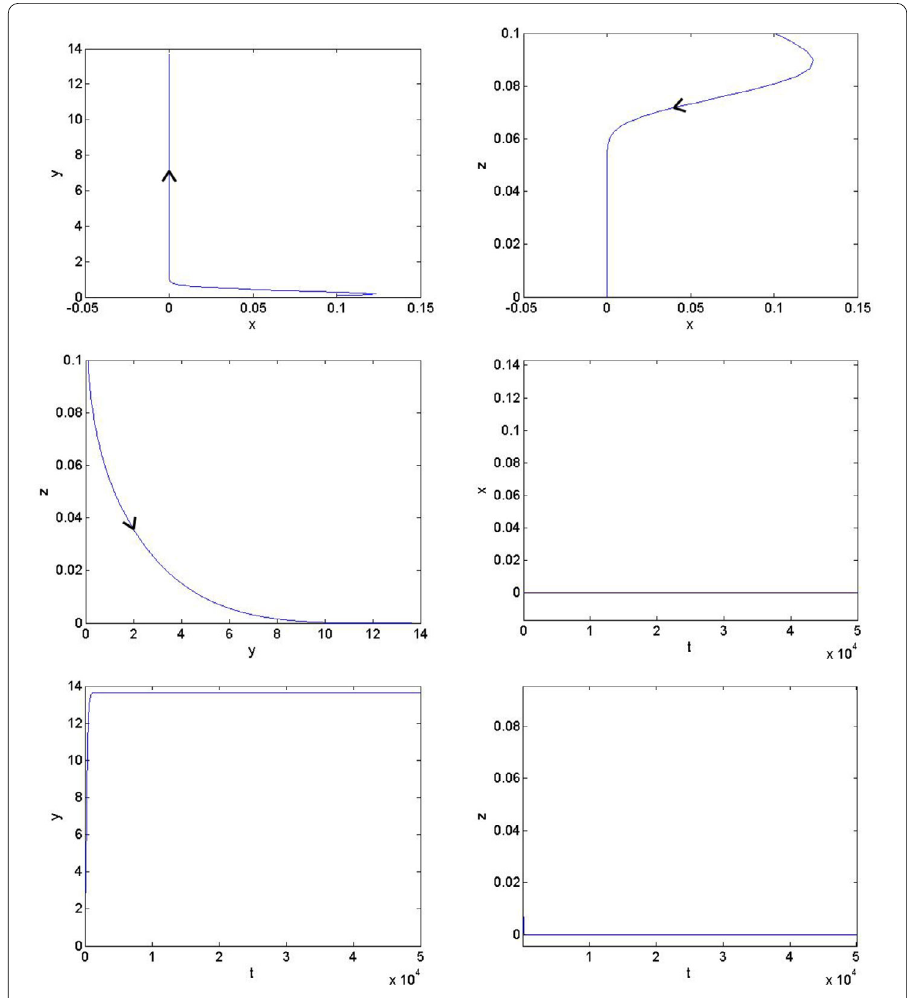
Figure 9 A computer simulation of the system of Eqs. (4)–(6) with c 1 = 0.2 day –1 , c 2 = 0.95 day –1 , c 3 = 0.239 day –1 , c 4 = 0.85 day –1 , c 5 = 0.1 day –1 , k 1 = 67, k 2 = 0.5, k 3 = 0.7, h 1 = 0.024, h 2 = 0.063, e 1 = 0.001 day –1 , e 2 = 0.06 day –1 , e 3 = 0.4 day –1 , γ 1 = 0.001 day –1 , γ 2 = 0.03 day –1 , (cid:8) = 0.1 and δ = 0.9